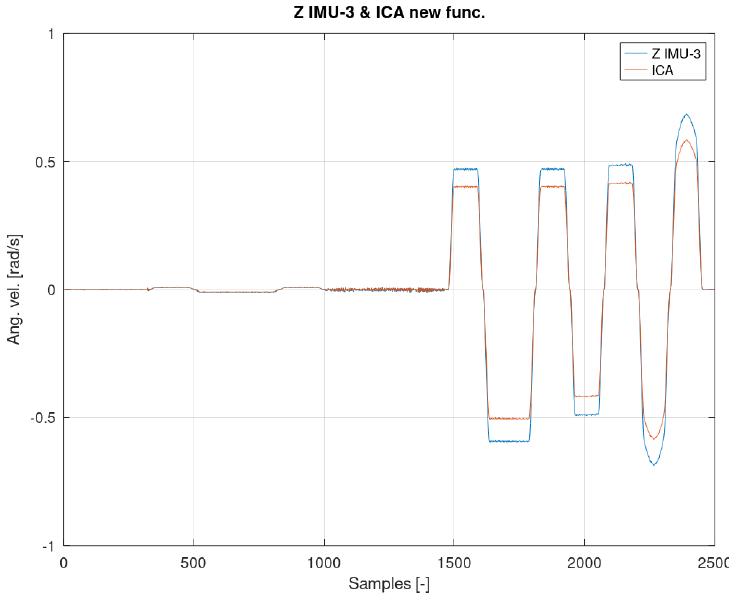
Figure 16. The result of the ICA algorithm on the basis of the activation Function (9).